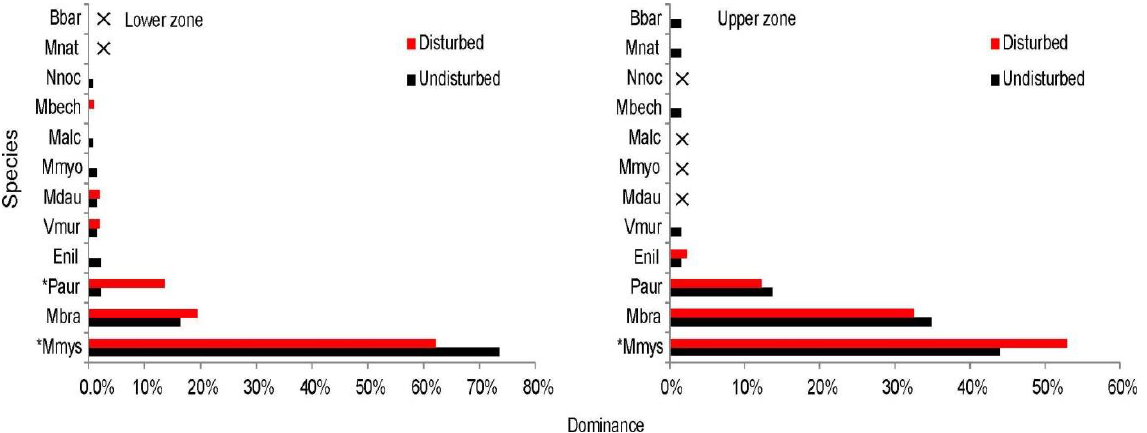
Figure 6. Rarefaction curves with 95% confidence intervals for species richness of bats ( A, B ) and diversity profile curve plotting Hill numbers ( C, D ) for the undisturbed and disturbed coniferous forests of the lower and upper forest zone in the Polish Tatra Mountains, 2016 – 2020.